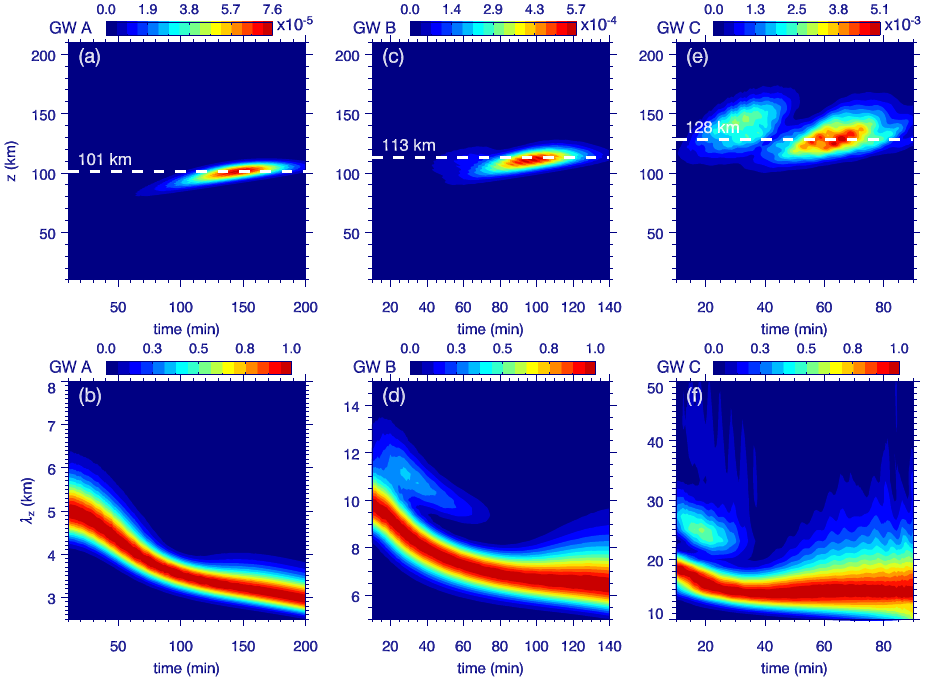
Fig. 9. Temporal evolutions of (a, c, e) momentum flux (unit is m 2 s − 2 ) and (b, d, f) normalized vertical wavelength power spectra for the cases of (left column) GW A, (middle column) GW B and (right column) GW C propagating in the non-isothermal atmosphere. The white dash lines show the heights of z diss . The scaling factors are shown at the right of the color